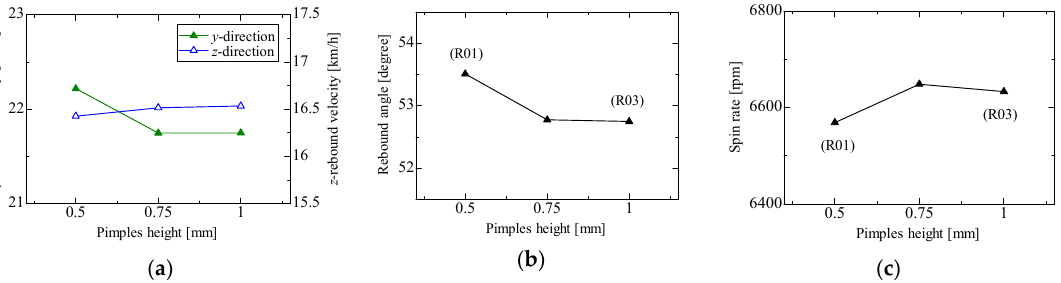
Figure 3. These figures show the simulation results of the rebound behavior of the ball with different pimple heights at incidence velocity and angle of 60 km/h and 70 degrees: ( a ) the 𝑦 and 𝑧 components of 𝑣 (cid:3042)(cid:3048)(cid:3047) ; ( b ) 𝜃 (cid:3042)(cid:3048)(cid:3047) ; ( c ) 𝜔 (cid:3042)(cid:3048)(cid:3047) . The 𝑦 and 𝑧 axes are defined as shown in Table